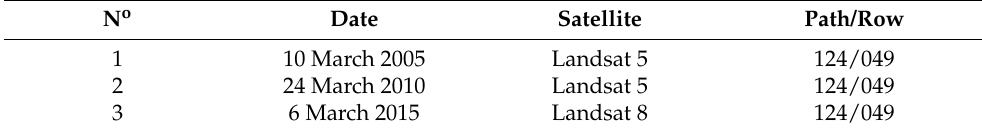
Table 1. Selected satellite images.